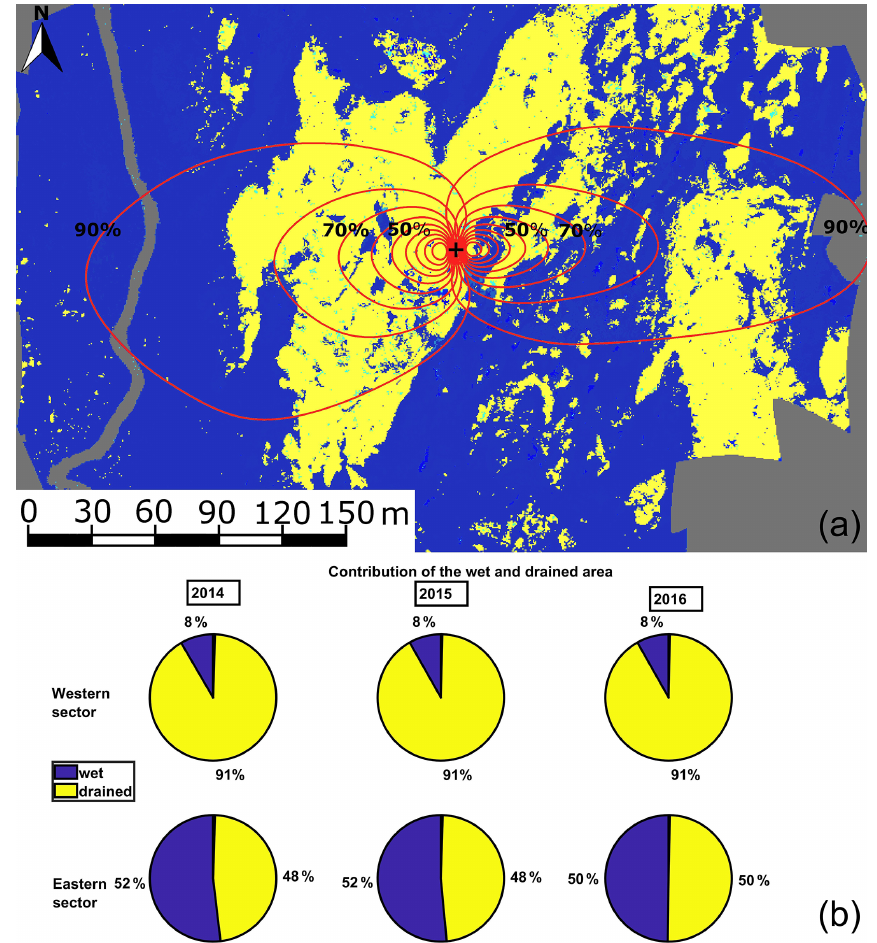
Figure 4. Footprint-weighted contribution of the wet and drained area at the SE-Sto tower (a) for the year 2014 and relative amounts of wetter areas (blue) and the drained palsa area (yellow) inside the 80% area of influence of the footprints (b) . The black cross is the location of the tower, and each red line indicates 10% of the contribution from the source area to measured fluxes at the tower. The footprint climatology is almost identical for all study years; see bottom